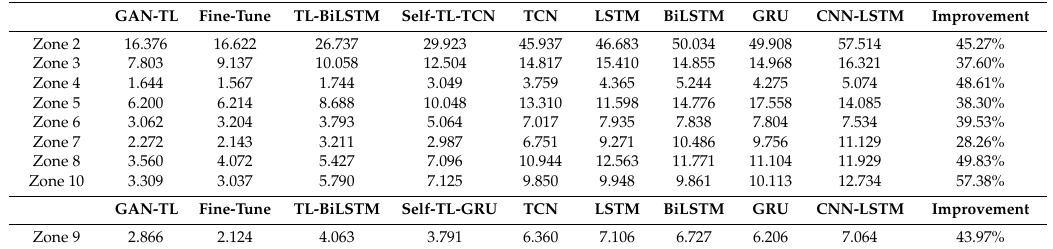
Table 8. RMSE scores for different models applied to nine target zones.